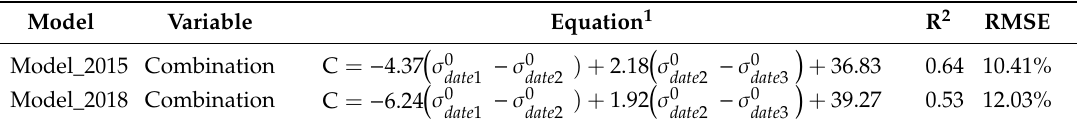
Table 2. Estimation models of forest canopy coverage used in the indirect method.